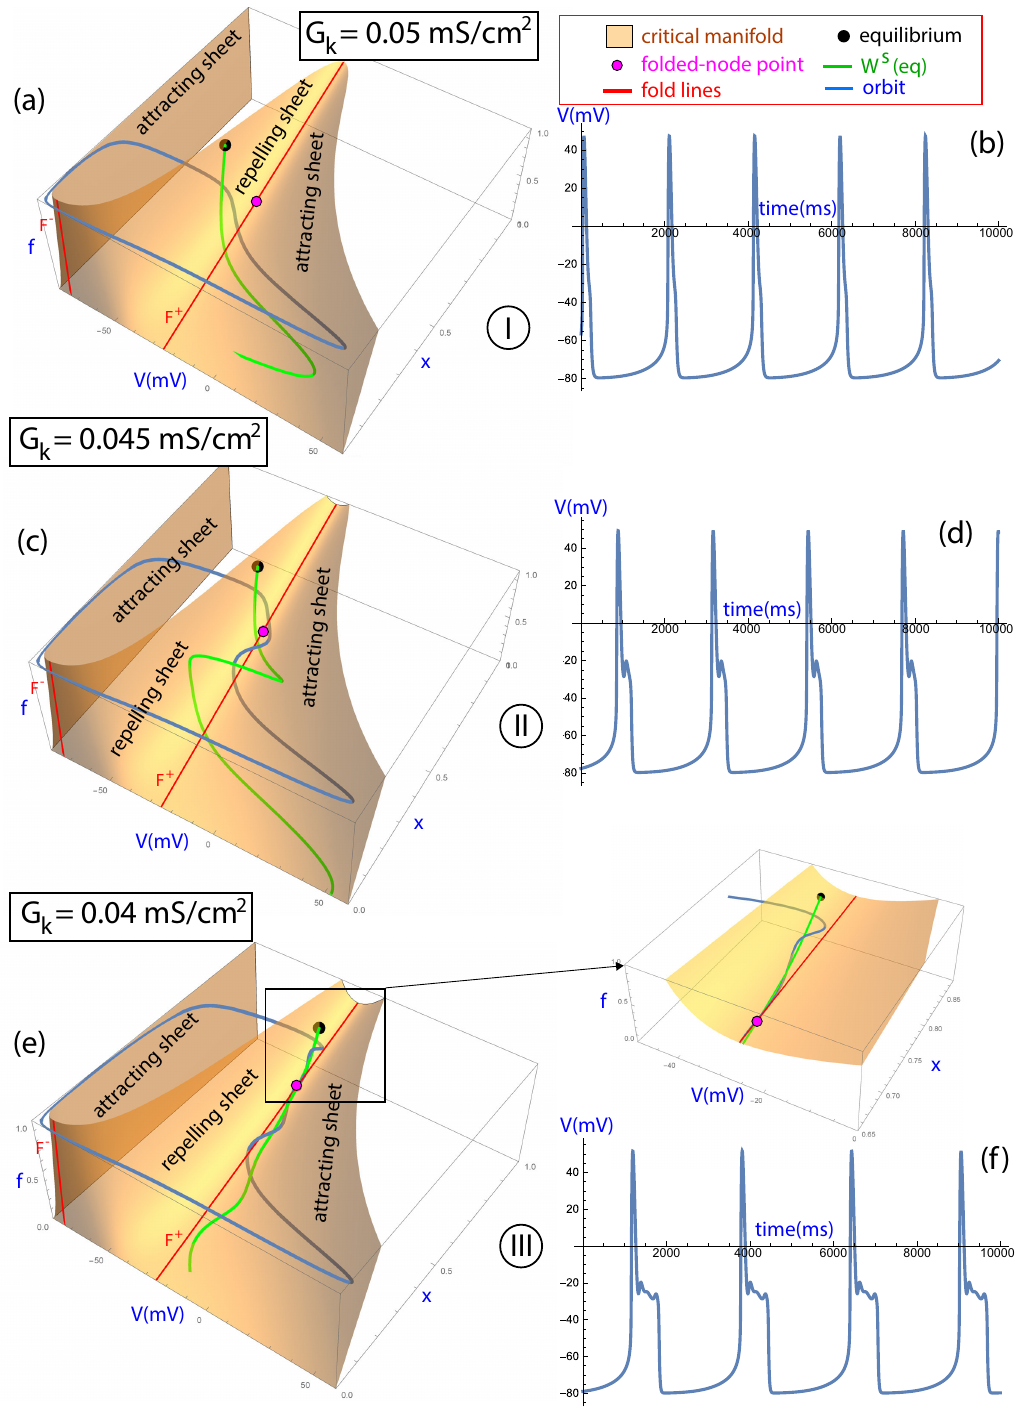
Figure 3. Analysis of cases I, II, and III on the line G Ca = 0.025. Plots ( a , c , e ): the critical manifold M critical (orange) is shown with the attracting and repelling sheets separated by the fold lines, F F − (red). The periodic orbit is shown in blue. As the bifurcation parameter G k is varied, the periodic orbit and the number of EADs change depending on the position of the equilibrium point (black), the folded-node point (magenta), and the stable manifold of the equilibrium (green). Plots ( b , d , f ): the temporal evolution in milliseconds of the variable V of the periodic orbit is